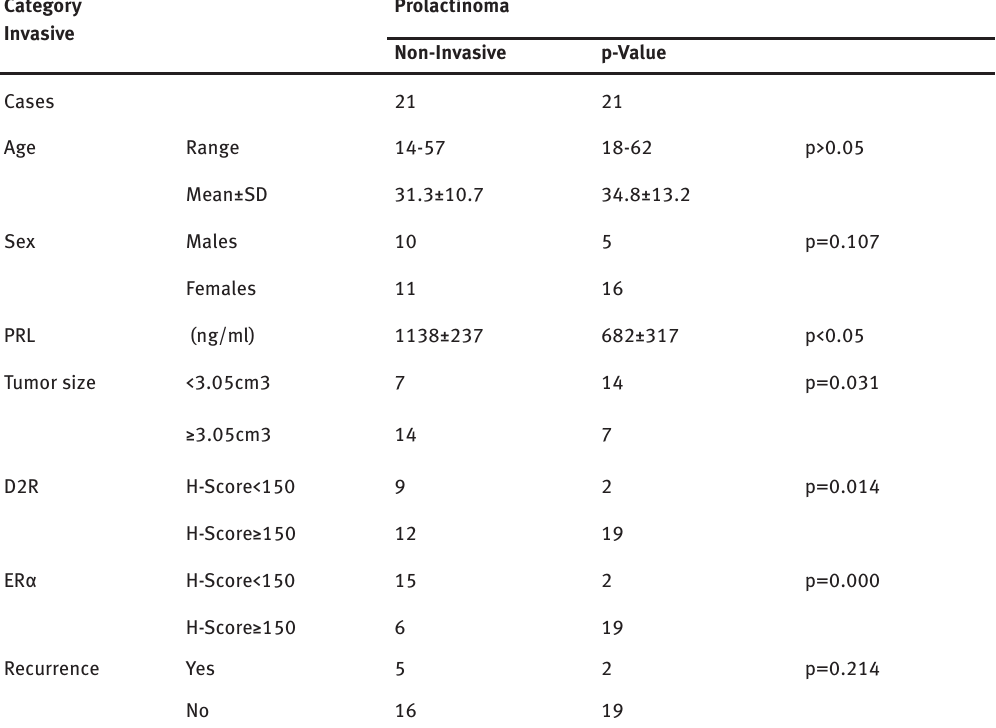
Table 1: The clinicopathological data in 42 prolactinomas cases. Category